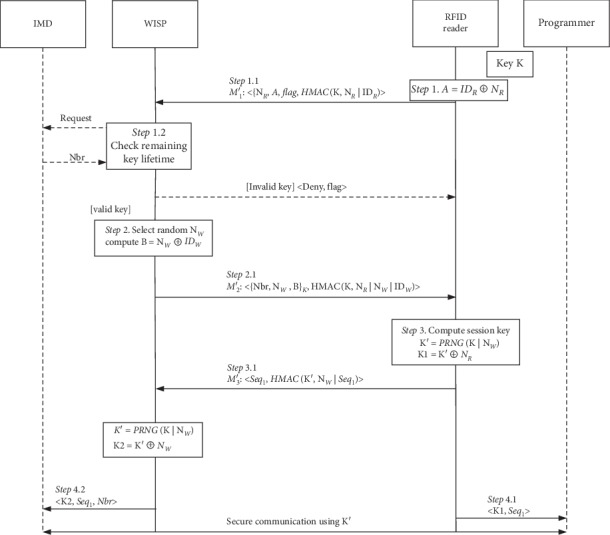
The proposed mutual authentication protocol in the regular mode (protocol 4) (Algorithm 2).